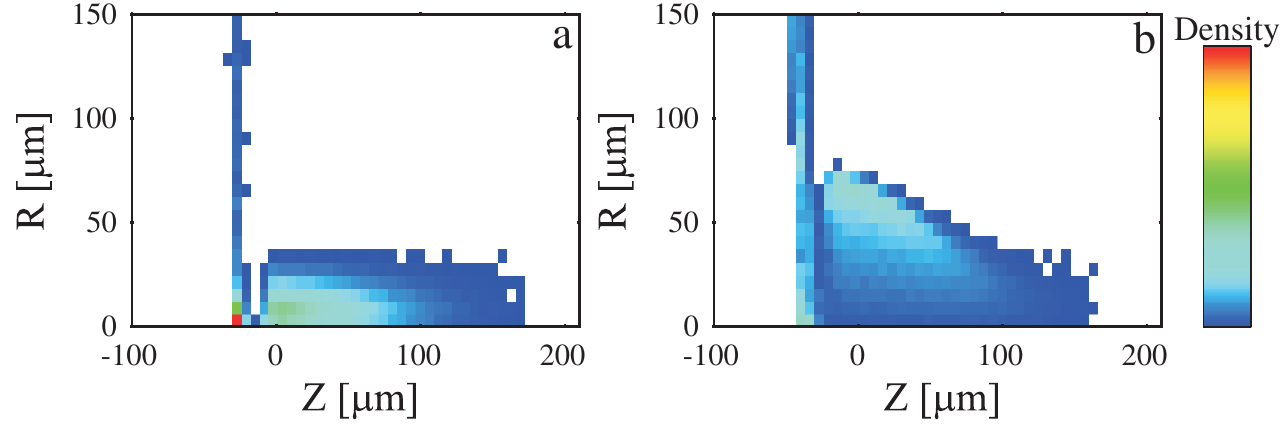
FIG. 14. (Color) Density plot of the radial profile of the bunch during trapping without (a) and with space charge